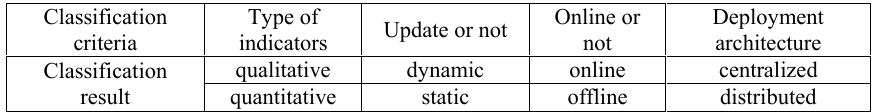
Table 1. Common classifications of trust